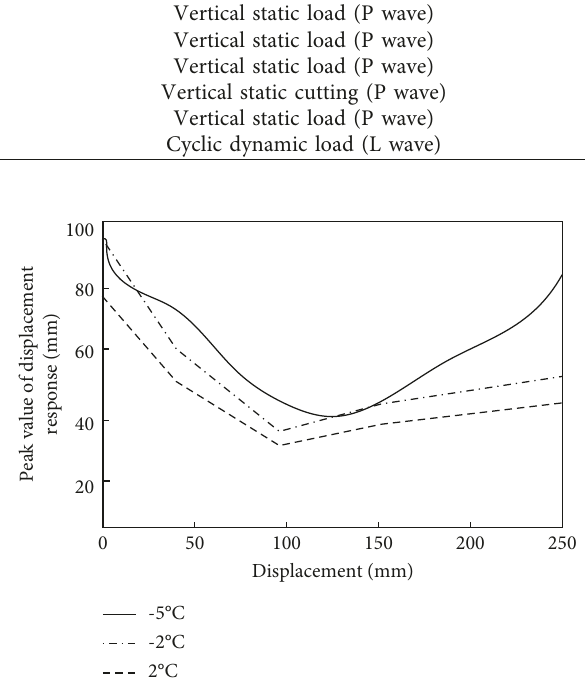
Figure 5: Analysis results of the seismic response characteristics of a single pile under different